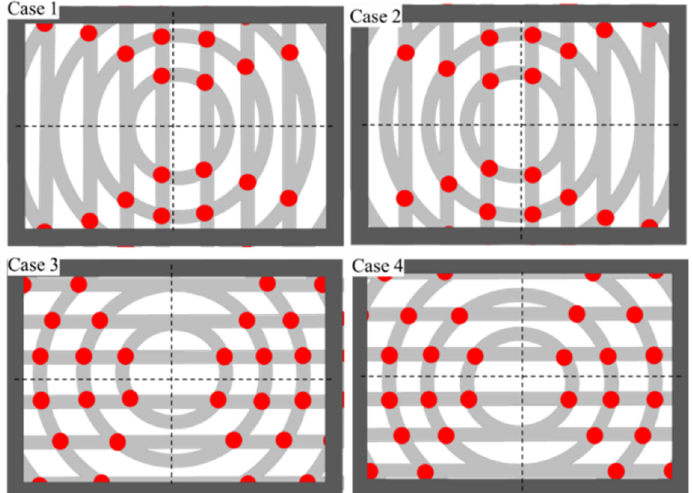
Figure 5. There are four angle detection results with offset ( 𝛥𝑠 (cid:3405) 0 ) Case1: 0°; Case2: 180°; Case3: 90°; Case4: 270°.